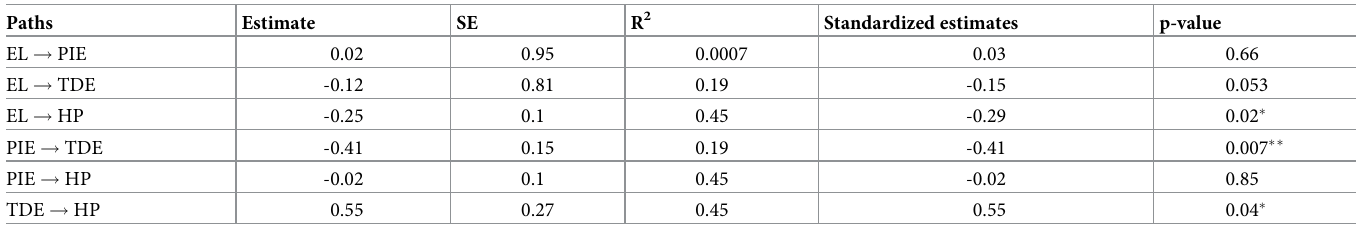
Table 7. The evaluations of path coefficients with respect to latent variables.